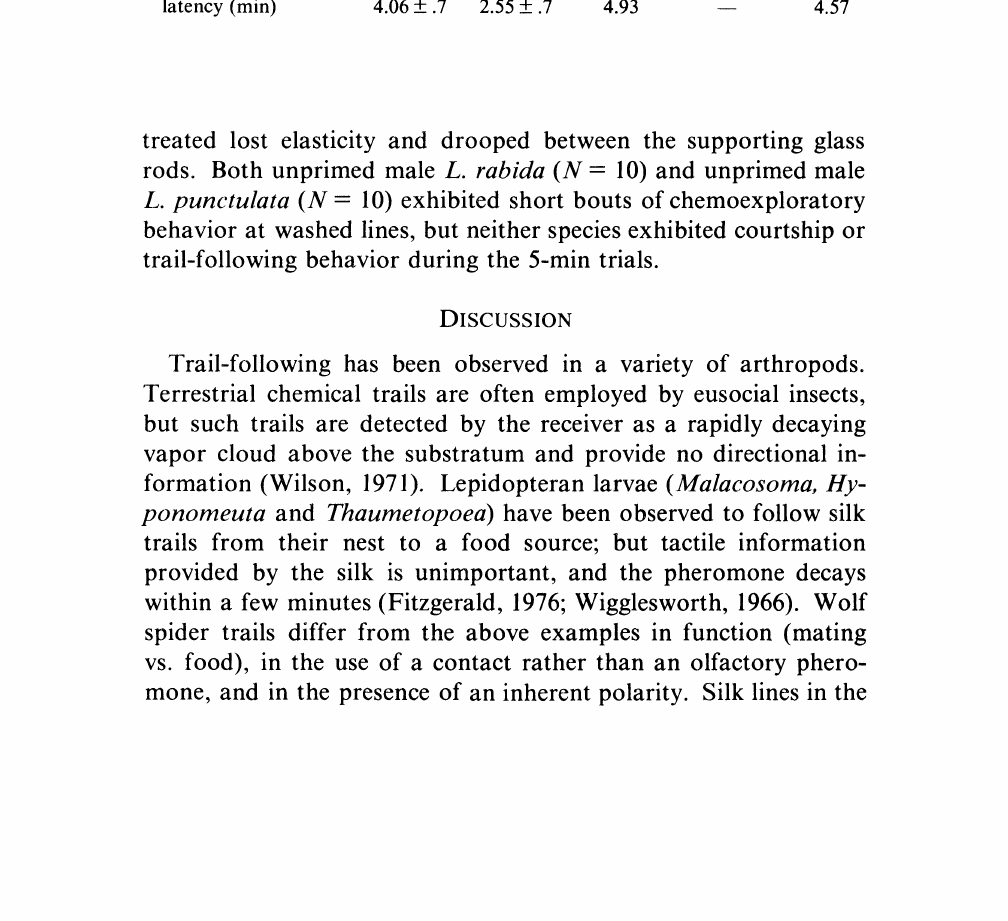
Table II. Courtship Responses to Various Types of Silk by Male Lycosa rabida and Male L. punctulata. Experimental Silks Female Male Female Clean